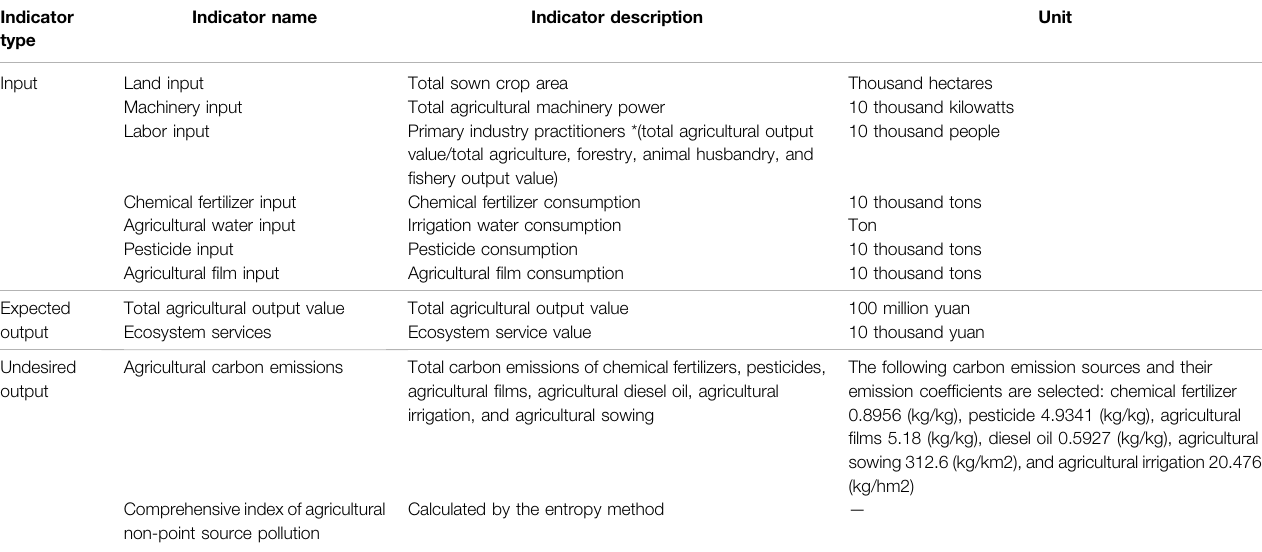
TABLE 1 | Agricultural Eco-ef fi ciency indicator system.